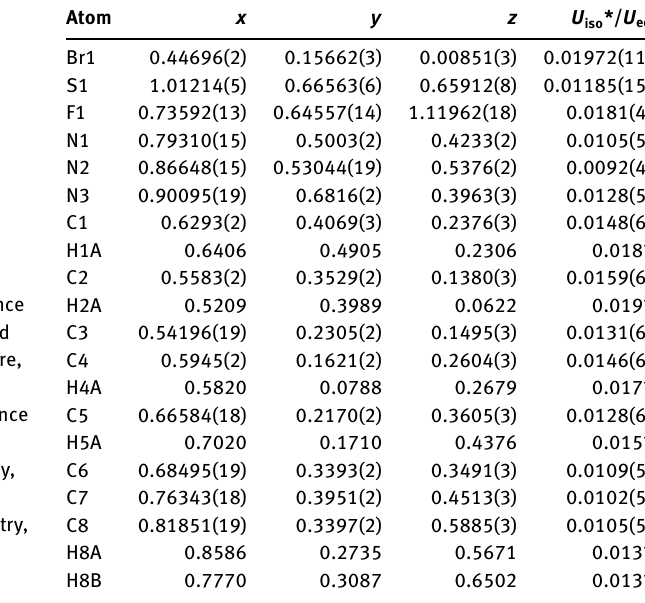
Table 2: Fractional atomic coordinates and isotropic or equivalent isotropic displacement parameters (Å 2